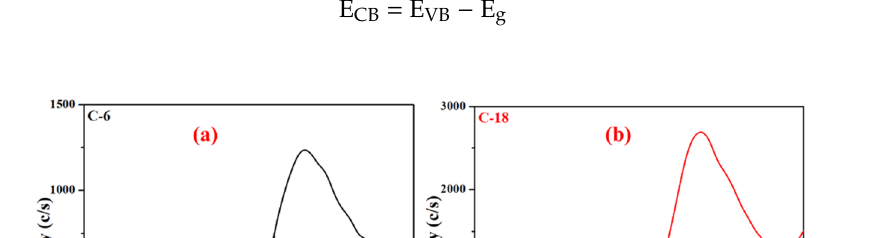
Figure 7. UV-vis diffuse reflectance absorbance spectra ( a ) and ( b ) optical bandgap measurements of CdS nanorods prepared at different reaction times.